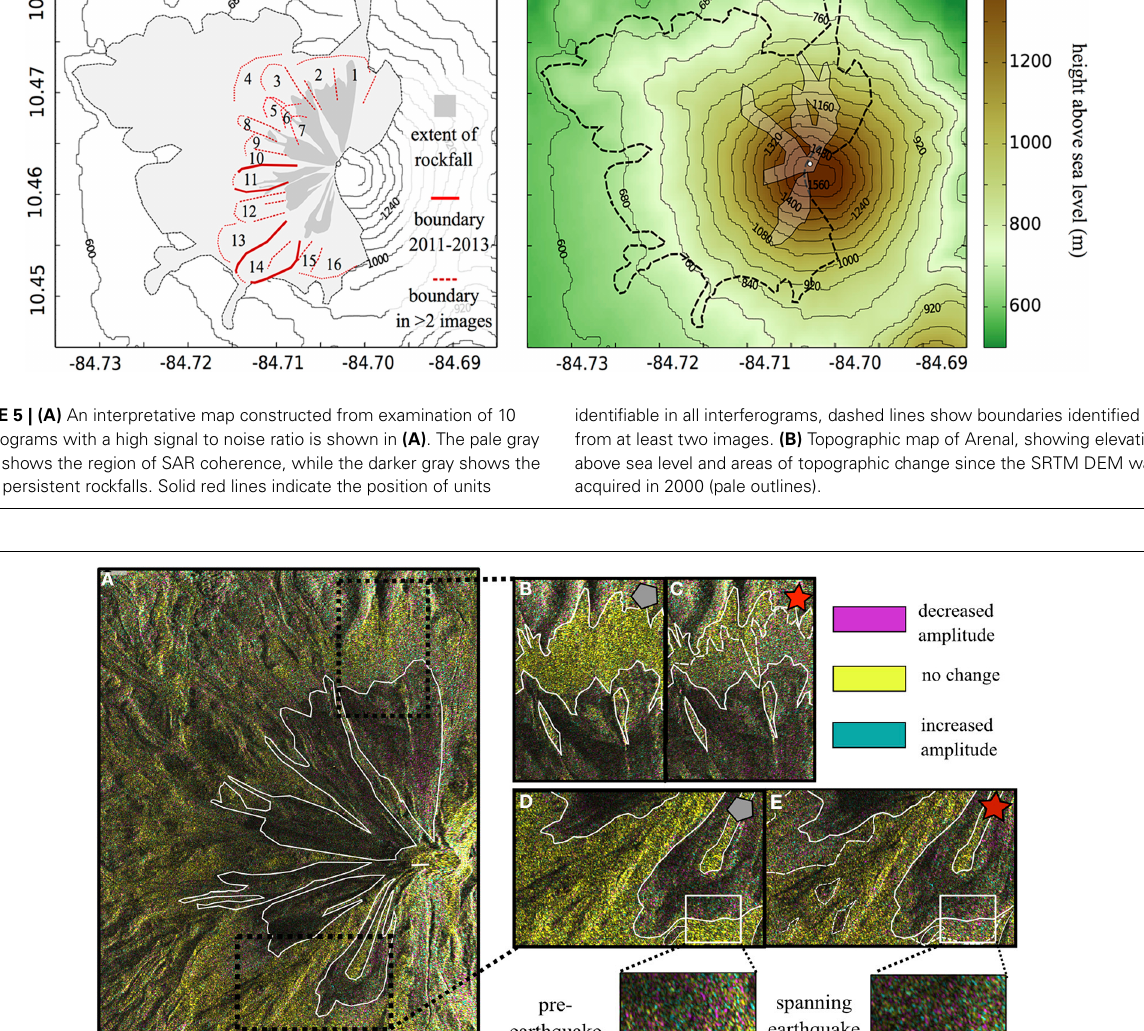
FIGURE 6 | RGB images representing intensity change, using the convention that the first image is red, second image is green and the scaled difference between them is blue (after Wadge et al., 2011). In the resulting image, yellow indicates no change in amplitude, magenta indicates a decrease, and cyan an increase. Bright yellow areas indicate smooth (on the 3cm scale) surfaces that have not changed. The darker regions are rougher and contain a complicated